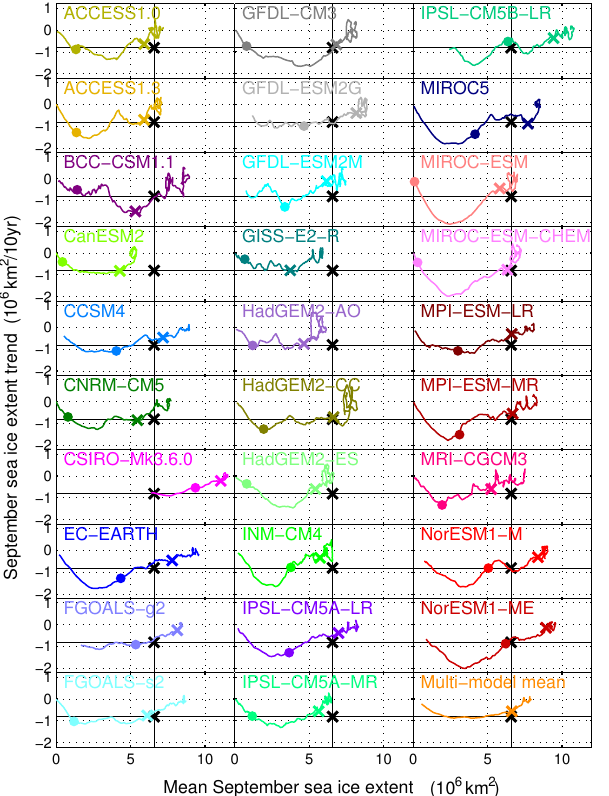
Fig. 4. Phase space of the SSIE as simulated by the CMIP5 models under RCP8.5: the mean SSIEs over consecutive 32-yr periods from 1850 to 2100 (x-axis) are plotted against the SSIE linear trends over the corresponding periods. The colored crosses indicate the current (1979–2010) position of the model on its trajectory. The colored dots are the model position over 2030–2061. The black cross is the current (1979–2010) state of the observed Arctic SSIE in this phase space. The reader can visualize a dynamic version of this figure at http://www.elic.ucl.ac.be/users/fmasson/CMIP5.gif (also available as Supplement).